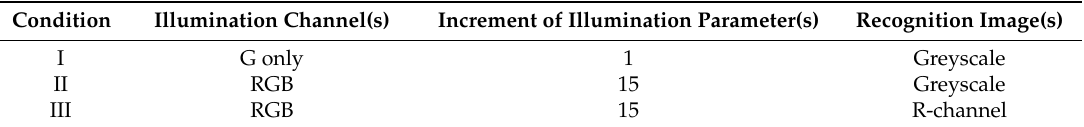
Table 2. Experimental